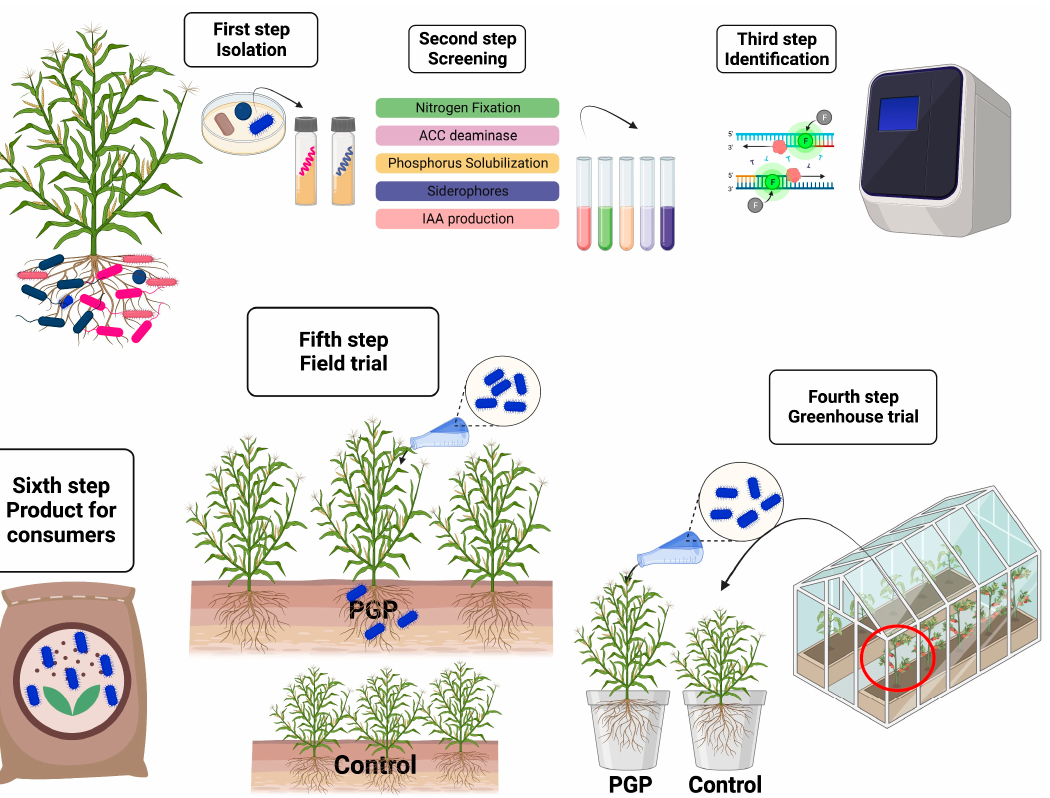
Figure 1. Schematic representation of the steps required to isolate and characterize bacteria that promote plant growth.